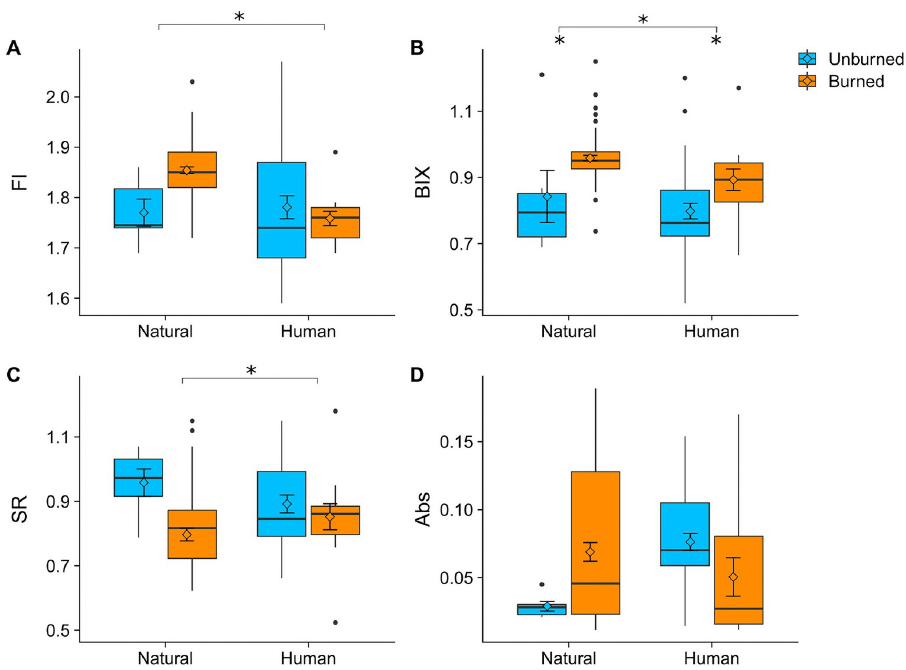
Fig 5. Optical properties of dissolved organic matter (DOM) from burned and unburned sites in natural and human watersheds. Optical parameters included fluorescence index (FI), biological index (BIX), slope ratio (SR), and absorbance (Abs). See [129] for detailed interpretation of optical